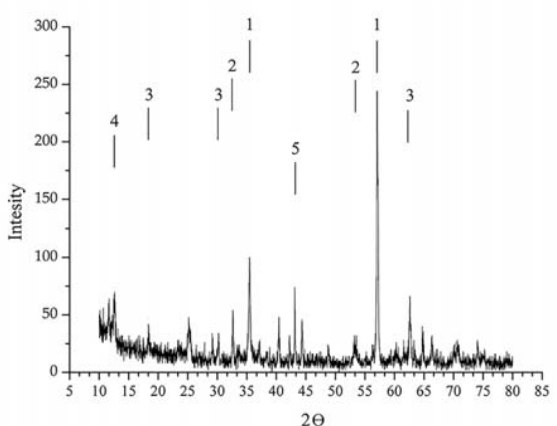
Figure 1. X-ray diffraction (XRD) patterns of titanomagnetite ore of the Chineisk deposit: (1)—Fe 3 O 4 , (2)—FeTiO 3 , (3)—MgFe 2 O 4 , (4)—Fe 3 ((FeSi)O 5 )(OH) 4 , (5)—AlFe monoclinic. Table 2. Mineralogical composition of titanomagnetite ore from the Chineisk deposit by XRD (%). Content Mass Fraction, wt % Lattice Parameters, Å Size of the Coherent Scattering Region, nm